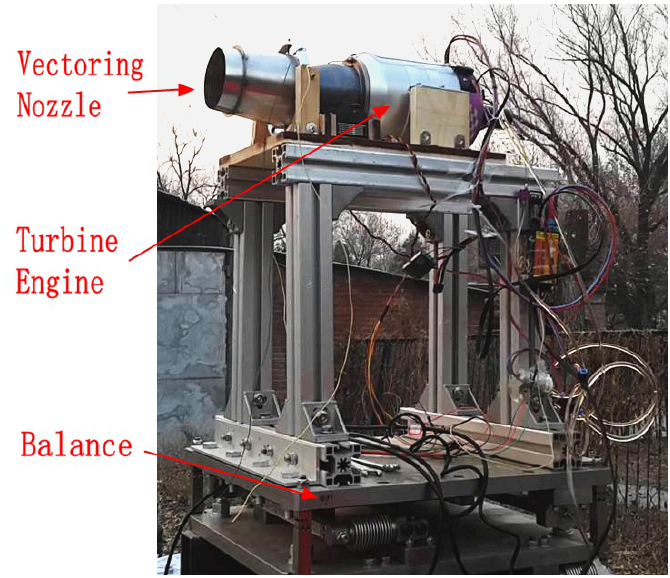
Figure 6. Engine thrust ground experiment platform.